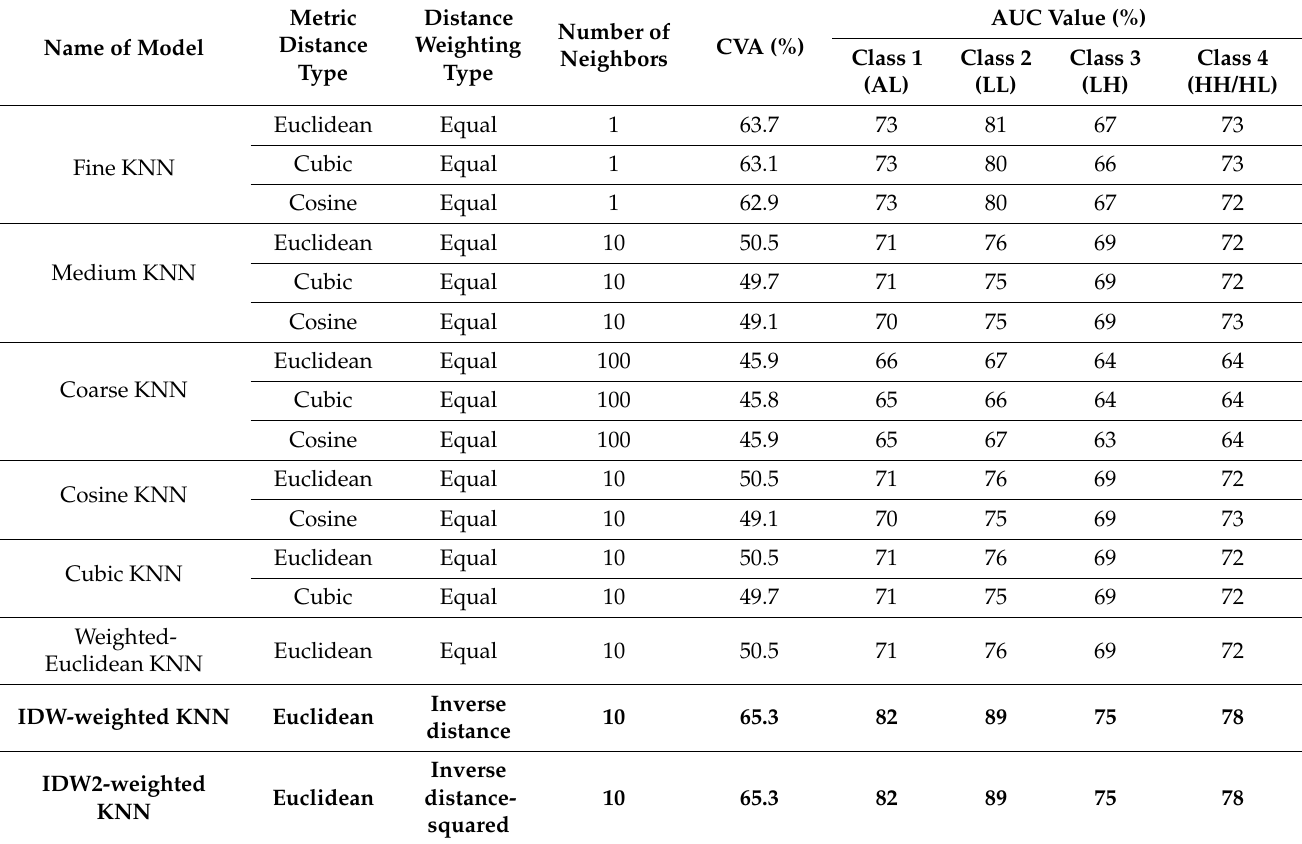
Table 6. Results of automatic classifications with KNN models. The best performing model that was selected for the KNN category is shown in bold